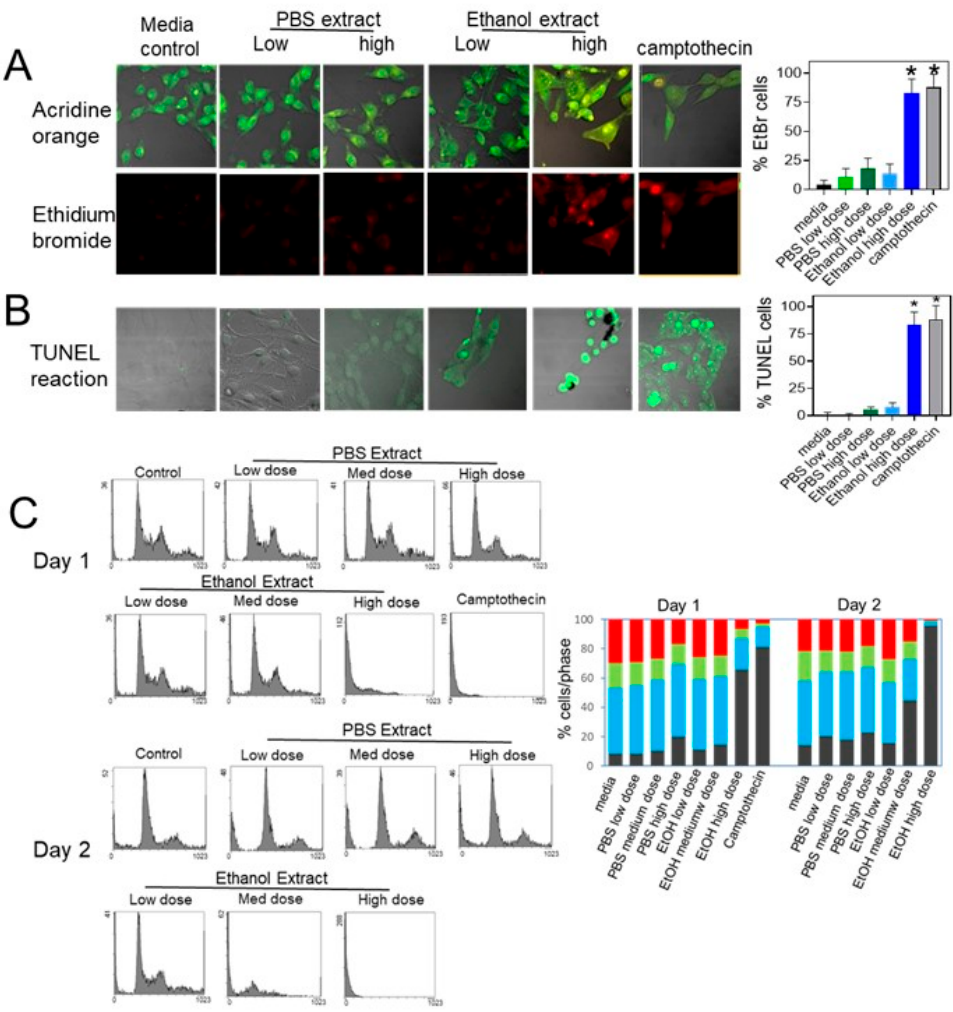
Figure 3. Effect of Uncaria tomentosa extracts on the induction of apoptosis by the B16-BL6 cells. B16-BL6 cells were treated with culture media (control), or low (4 µ g/mL), medium (40 µ g/mL), or high doses (100 µ g/mL) of Uncaria tomentosa extracted with 70% ethanol or PBS, or with 6 µ g/mL Camptothecin (positive control): ( A ) fluorescence images were obtained for cells treated with Uncaria tomentosa extracts for 3 days and then stained with acridine orange (green) or ethidium bromide (red). The bar graph shows the % of cells stained with ethidium bromide; ( B ) cells treated for 2 days were stained by incubation with TUNEL reaction mixture to detect DNA fragmentation and the monolayers were analyzed using a fluorescence microscope and representative photos showing an overlay of the fluorescence channel (excitation at 488 nm and emission at 520 nm) and phase contrast channel are shown. The bar graph shows the % of cells that are positive for DNA fragmentation from three independent experiments. Differences from control were considered significant (*) when p ≤ 0.05 by a Tukey post hoc test; ( C ) flow cytometry of B16-BL6 cells treated with extracts of Uncaria tomentosa for 24 and 48 h and incubated with propidium iodide was used to determine the proportion of cells with a sub-G1 DNA concentration indicative of induction of apoptosis. The percentage of cells in the sub-G1 (black), G1 (blue), S (green) and G2 phases (red) are shown as the mean of three independent